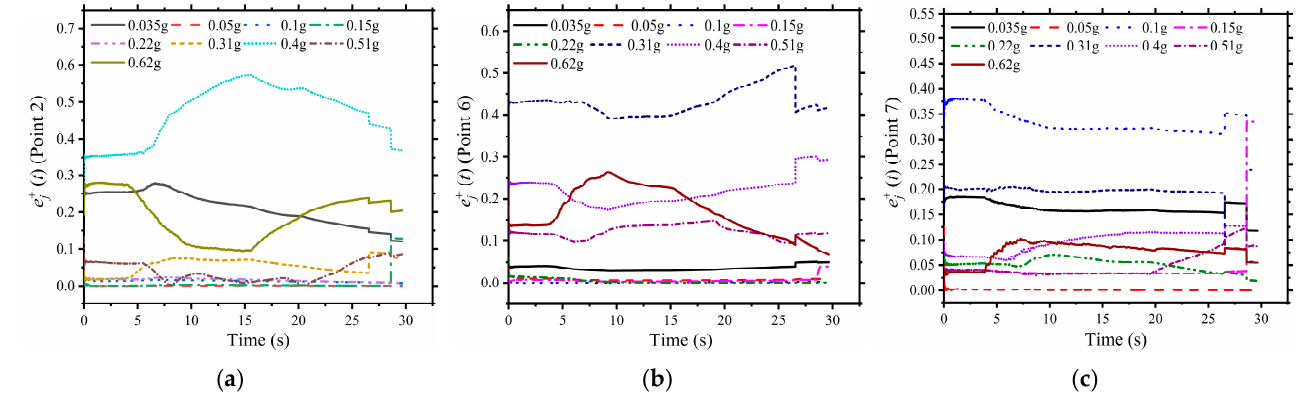
Figure 4. The curves of state variables 𝑒 (cid:2870)(cid:3037)(cid:2878) (𝑡) , 𝑒 (cid:2874)(cid:3037)(cid:2878) (𝑡) , and 𝑒 (cid:2875)(cid:3037)(cid:2878) (𝑡) : ( a ) Point P2, ( b ) Point P6, ( c ) Point P7.